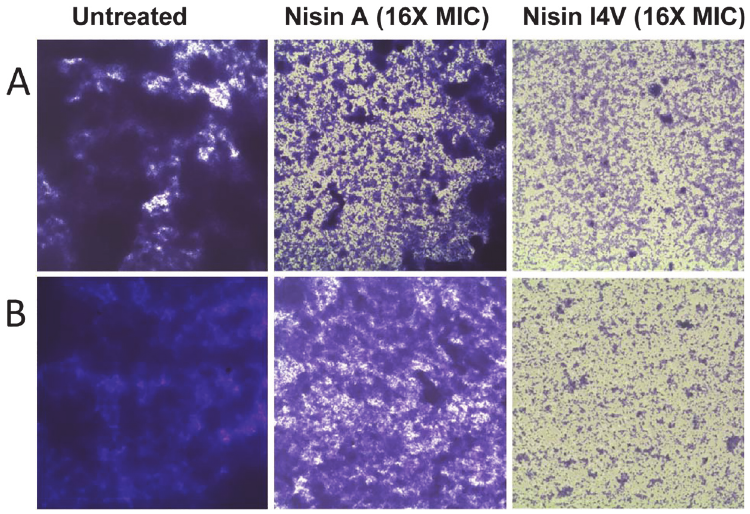
Fig 6. Morphology of nisin-treated biofilms examined by microscopy. (A) Examination of S. pseudintermedius DK729 and (B) S. pseudintermedius DSM21284 biofilms (magnification 1000X) after 24 hour treatment with 16X MIC of nisin A (Wt) and nisin I4V